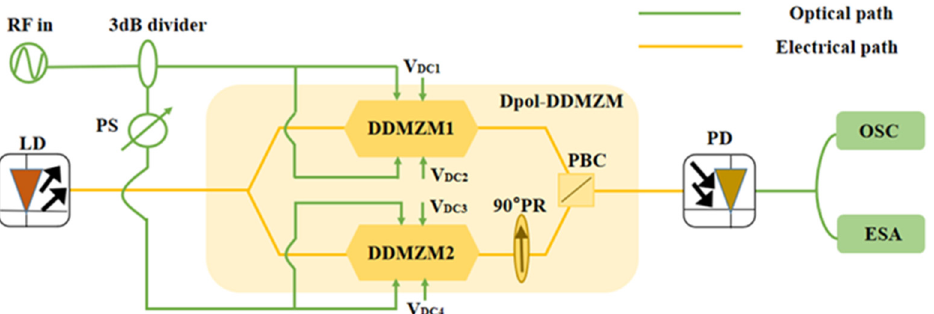
Figure 1. Schematic diagram of arbitrary waveform generation based on Dpol-DDMZM. PS: Phase Shifter; PR: Polarization Rotator; PBC: Polarization Beam Combiner; OSC: Oscilloscope; ESA: Electrical spectrum analyzer. ( )